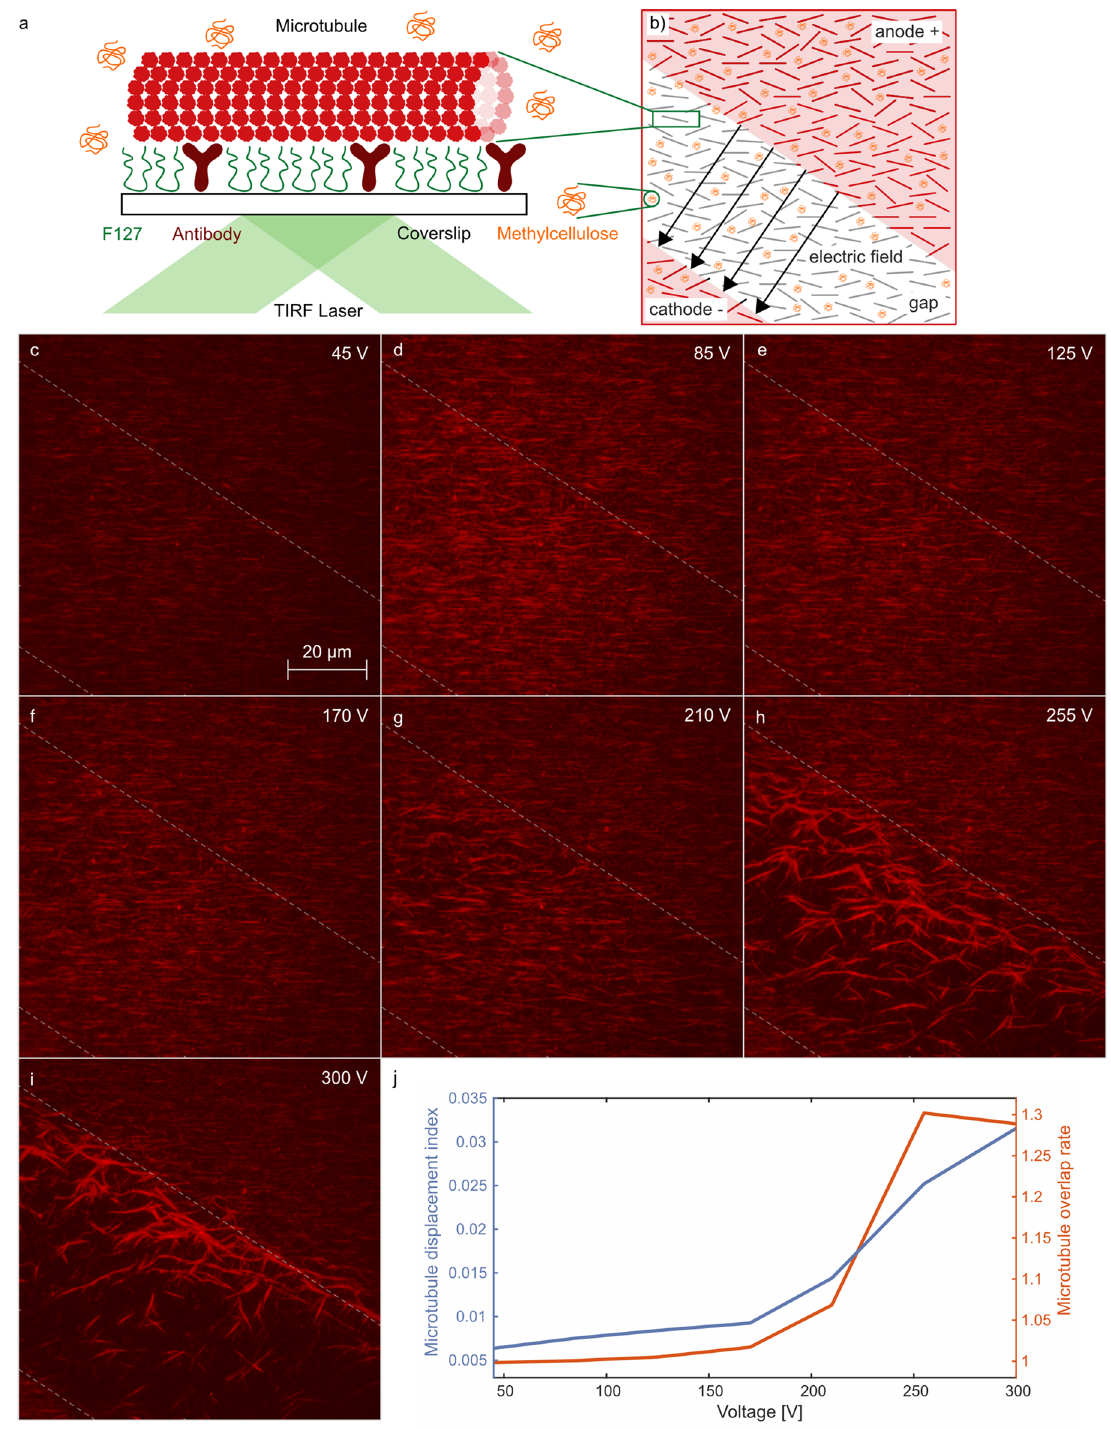
Figure 3. Pulse voltage dependence of microtubule displacement. A series of 5 µ s, N = 100 pulses, with 10 Hz firing frequency were applied at each voltage. (a) MTs are bound to the coverslip surface via antibodies. (b) Scheme of the microscope field of view covering the gap between the electrodes, (c) – (i) snapshots from TIRF microscope imaging show MTs (red) after µ s-PEF treatment. Dashed lines represent approximate position of projection of the borders of the electrodes to the image plane. (j) Microtubule displacement index and microtubule overlap rate . The data in this figure was collected sequentially on the same chip, sample, and field of view, starting with 45 V, then 85 V, 125 V, 170 V, 210 V, 255 V, and 300 V; thus, the observed effects were